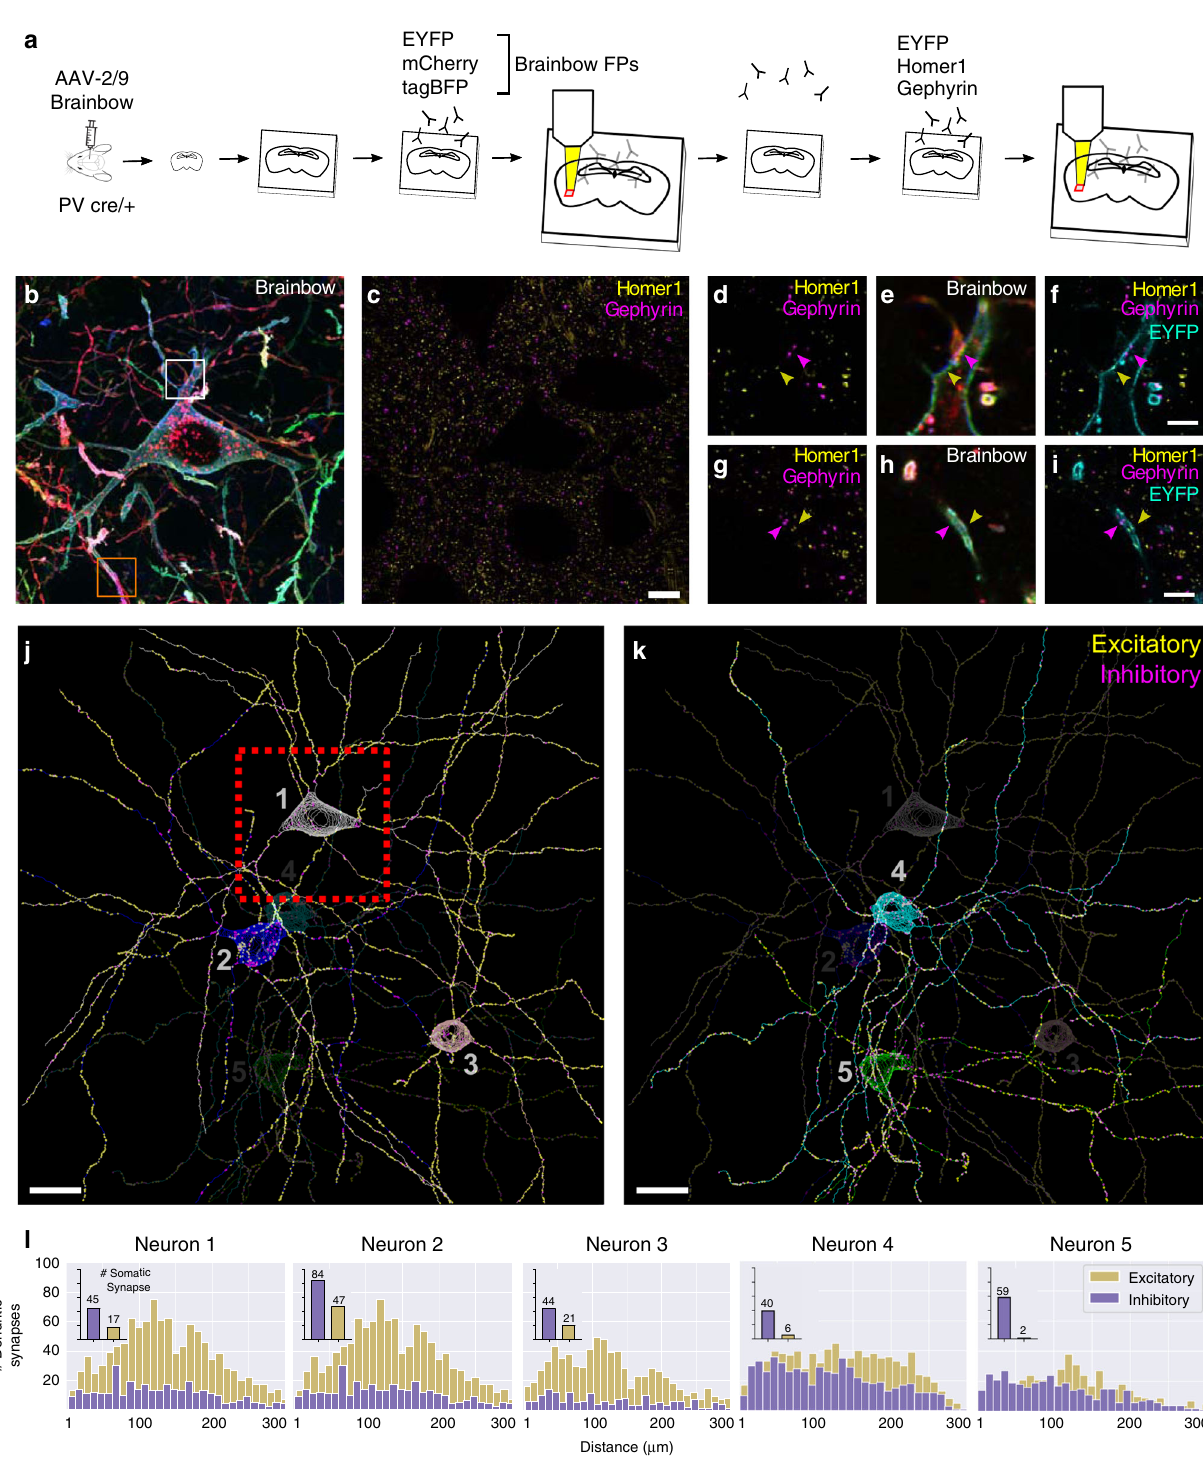
Fig. 5 Putative excitatory and inhibitory synapses of aspiny inhibitory neurons can be quanti fi ed. a Experiment design: Brainbow and endogenous PSD markers are imaged across two rounds of immunostaining using the EYFP channel for registration. b MIP of the three Brainbow channels imaged in round 1. c Single slice of excitatory (Homer1) and inhibitory (Gephyrin) PSDs imaged in round 2. d – i Zoomed in synaptic marker + Brainbow single slice images of the white square (top row) and orange square (bottom row) respectively. Yellow and purple arrows point to excitatory and inhibitory synaptic puncta respectively. j , k nTracer reconstruction of fi ve neurons ’ morphology and putative synaptic inputs. The red box represents the fi eld of view seen in b , c . l Histogram of the number of putative dendritic synapses as a function of dendritic length away from the soma for each neuron ( n = 5 neurons from one experiment). The inset bar graph represents the number of putative somatic synapses for each neuron. Scale bars: ( c ) 10 μ m (pre-expansion size), ( f , i ) 2.5 μ m (pre-expansion size), ( j , k ) 20 μ m (pre-expansion size). Expansion factor: ( b – i ) ~4×. See Supplementary Table 1 for more